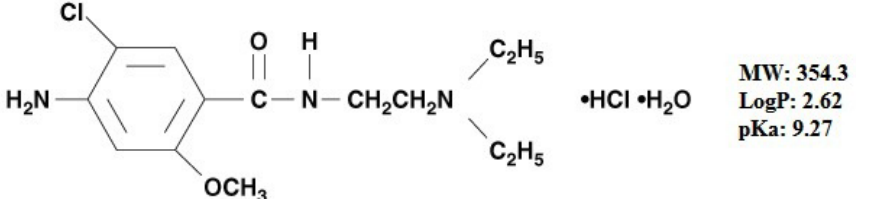
Figure 2. Chemical structure and properties of MTC